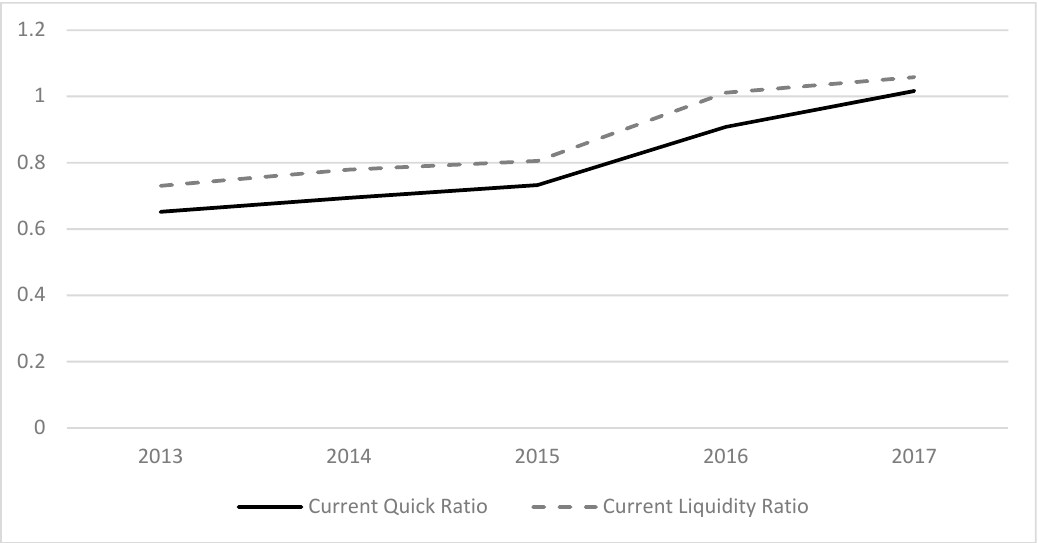
Figure 2. Median of ratios by years.